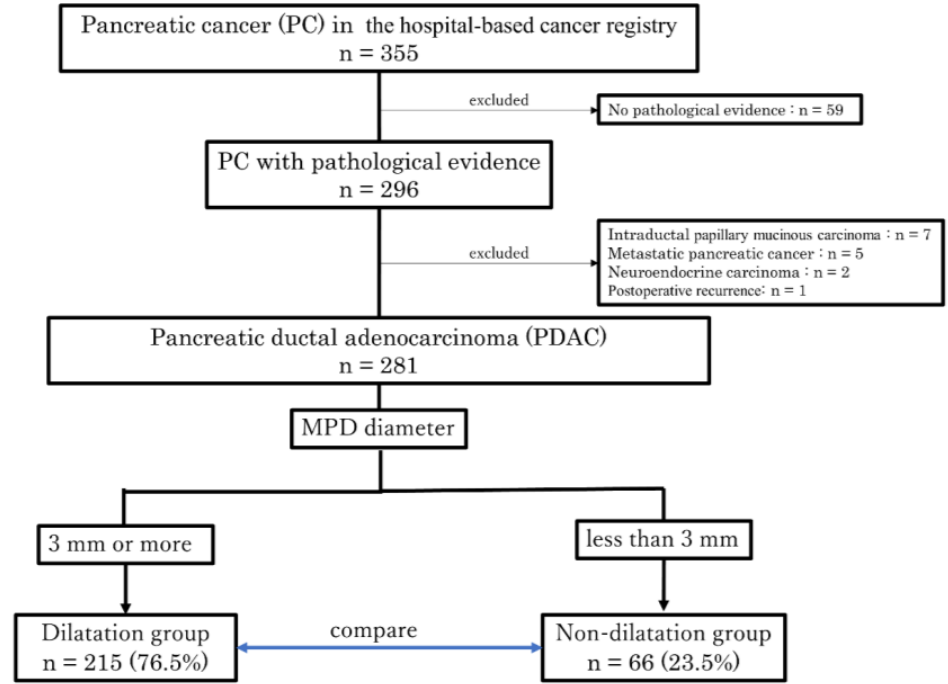
Figure 1. Patient selection flow diagram. A flow diagram illustrating the process of enrolling and selecting patients with PDAC for this study. A total of 281 patients were divided into the dilatation group, consisting of cases with MPD dilation to 3 mm or more, and the non-dilatation group, consisting of cases with MPD dilation less than 3 mm. After that, the two groups were compared for the set outcomes. MPD, main pancreatic duct.